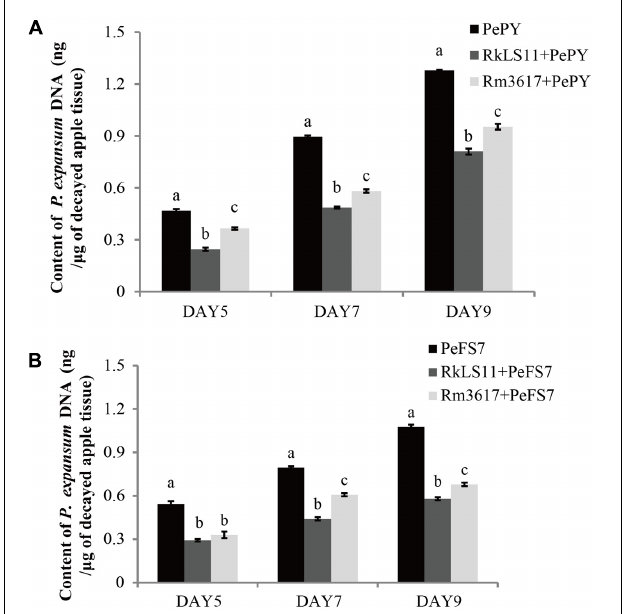
FIGURE 5 | Time course quantification of DNA of P. expansum strains PY and FS7 in infected apples pretreated and untreated with the BCAs R. mucilaginosa 3617 and R. kratochvilovae LS11. Concentrations of DNA were expressed as ng of fungal DNA/mg of decayed apple tissue. (A) DNA of P. expansum strain PY. (B) DNA of P. expansum strain FS7. PePY, P. expansum strain PY; PeFS7, P. expansum strain PeFS7; Rm3617, Rhodotorula mucilaginosa strain 3617; RkLS11, R. kratochvilovae strain LS11. Bars represent the mean values from two experiments ± standard deviations. Values marked with different letters are significantly different ( P < 0.05).